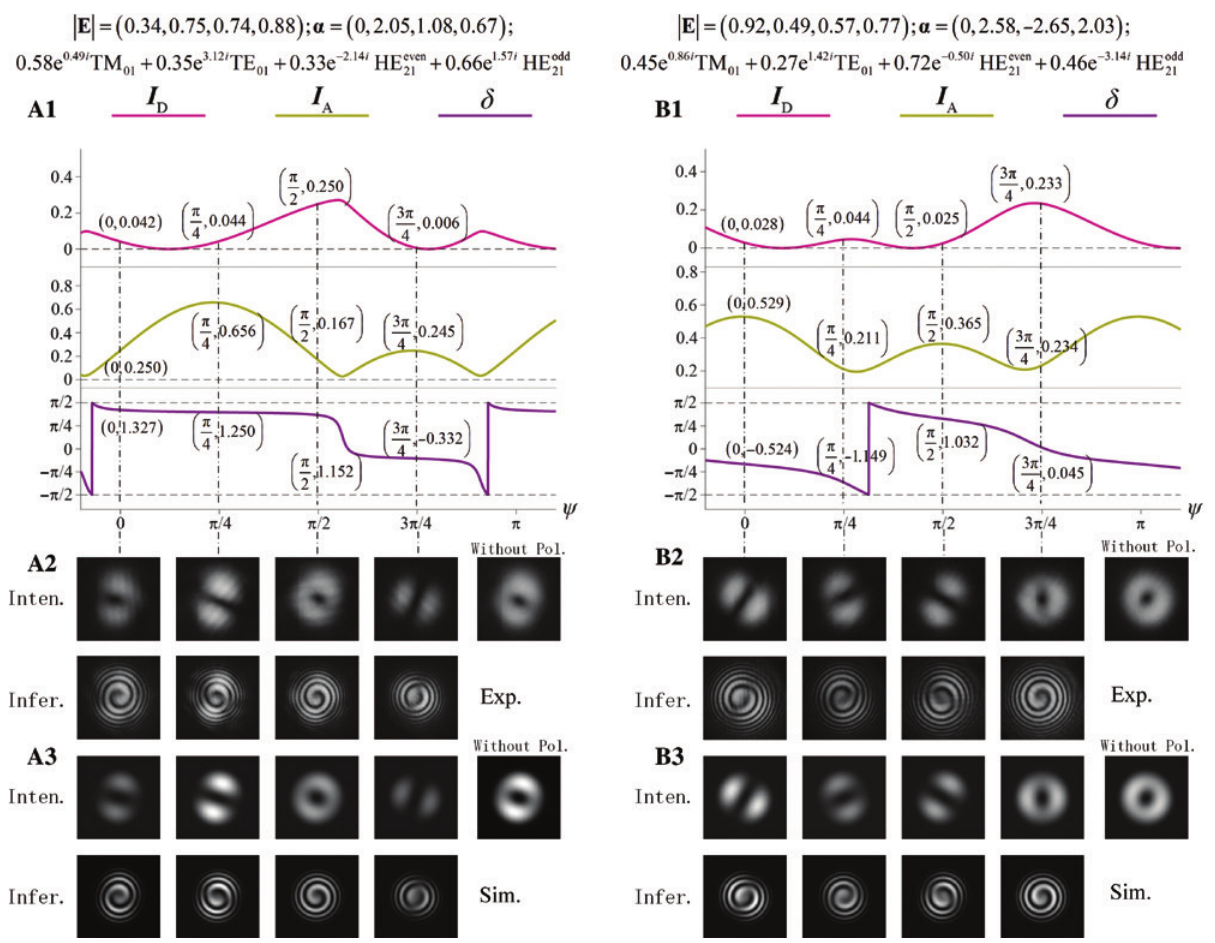
Figure 5: Corresponding relation between the expanded Jones model and mode patterns of random spatial states. (A) | E | = (0.34, 0.75, 0.74, 0.88), α = (0, 2.05, 1.08, 0.67) or bases. (B) | E | = (0.92, 0.49, 0.57, 0.77), α = (0, 2.58, −2.65, 2.03)